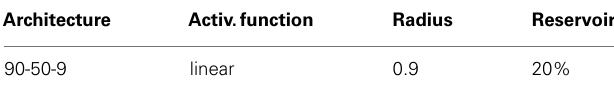
FIGURE 14 |The development of rewards decomposed into action/target combinations. x -axis denotes episodes, y -axis denotes the cumulative rewards (during an episode). Table 3 | Final parameters for training of theAN